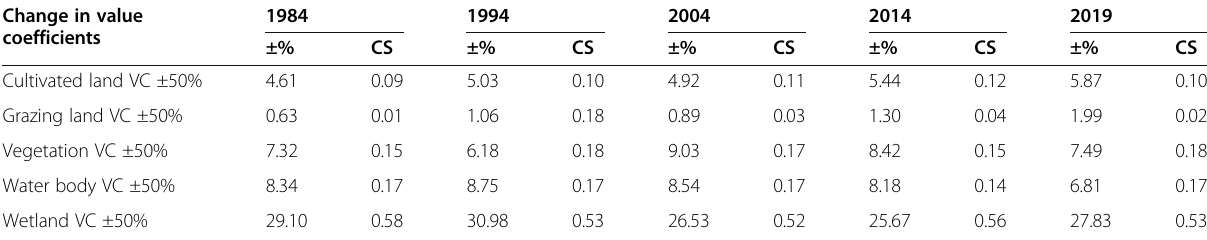
Table 10 Percentage change of the total estimated ecosystem service values and sensitivity coefficient ( CS ) after a 50% adjustment of value coefficients (VC) for each land use/land cover type in the Bahir Dar City (1984 –